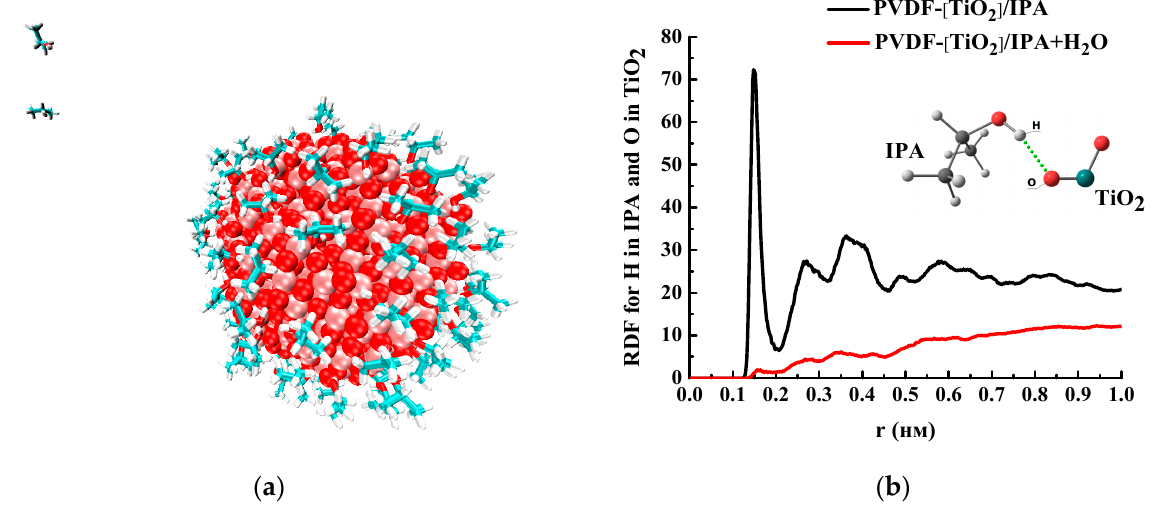
Figure 15. ( a ) Snapshot of the PVDF-[TiO 2 ]/IPA system (PVDF atoms are hidden for clarity). ( b ) Pair radial distribution function for O and H atoms of TiO 2 and water molecules, respectively.